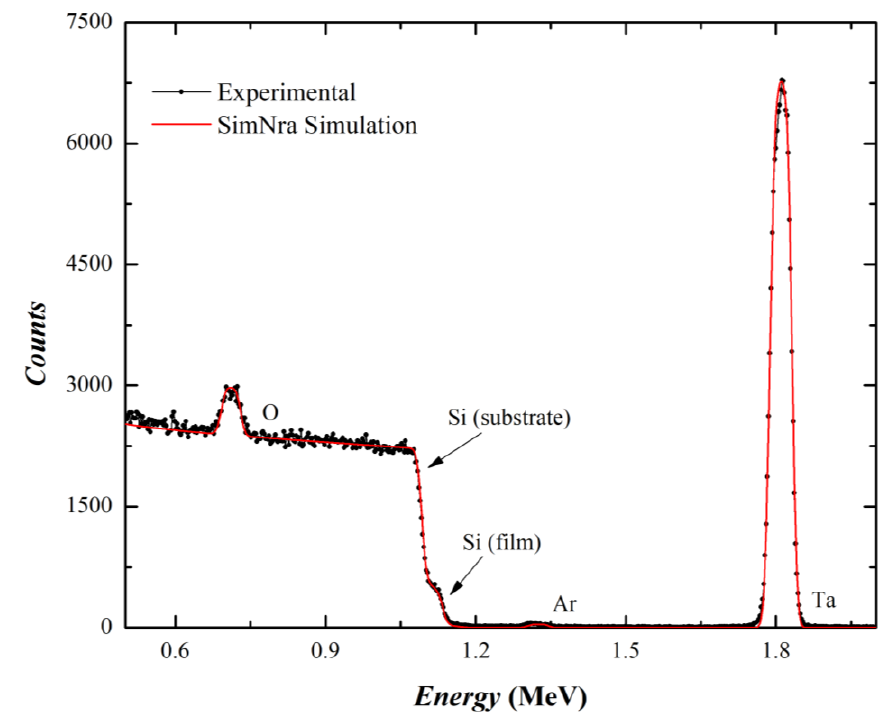
Figure 1. Experimental and simulated RBS spectra of the mixed oxide film – sample#3.